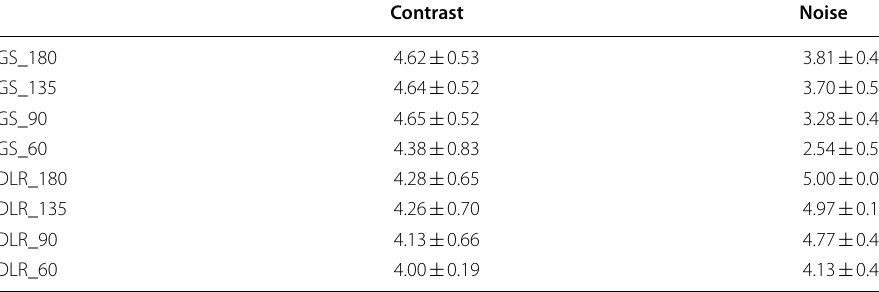
Table 2 Qualitative image quality